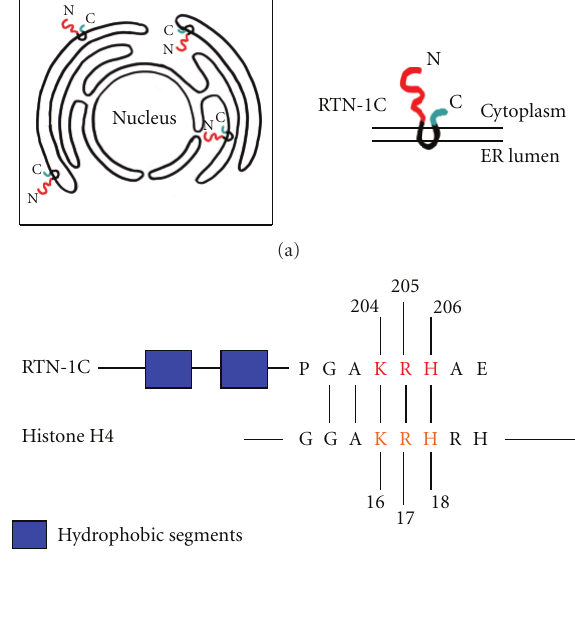
Figure 1: (a) Scheme showing the reticulons distribution on endo- plasmic reticulum and the physical connection between nuclear envelope and ER membrane. (b) Schematic diagram of RTN-1C and histone H4 proteins showing the shared GAKRH motif. The blue aminoacids indicate the two hydrophobic segments of RTN- 1C protein. The red aminoacids indicate the three positive charges in the H4 consensus motif. RTN-1C is acetylated on Lys